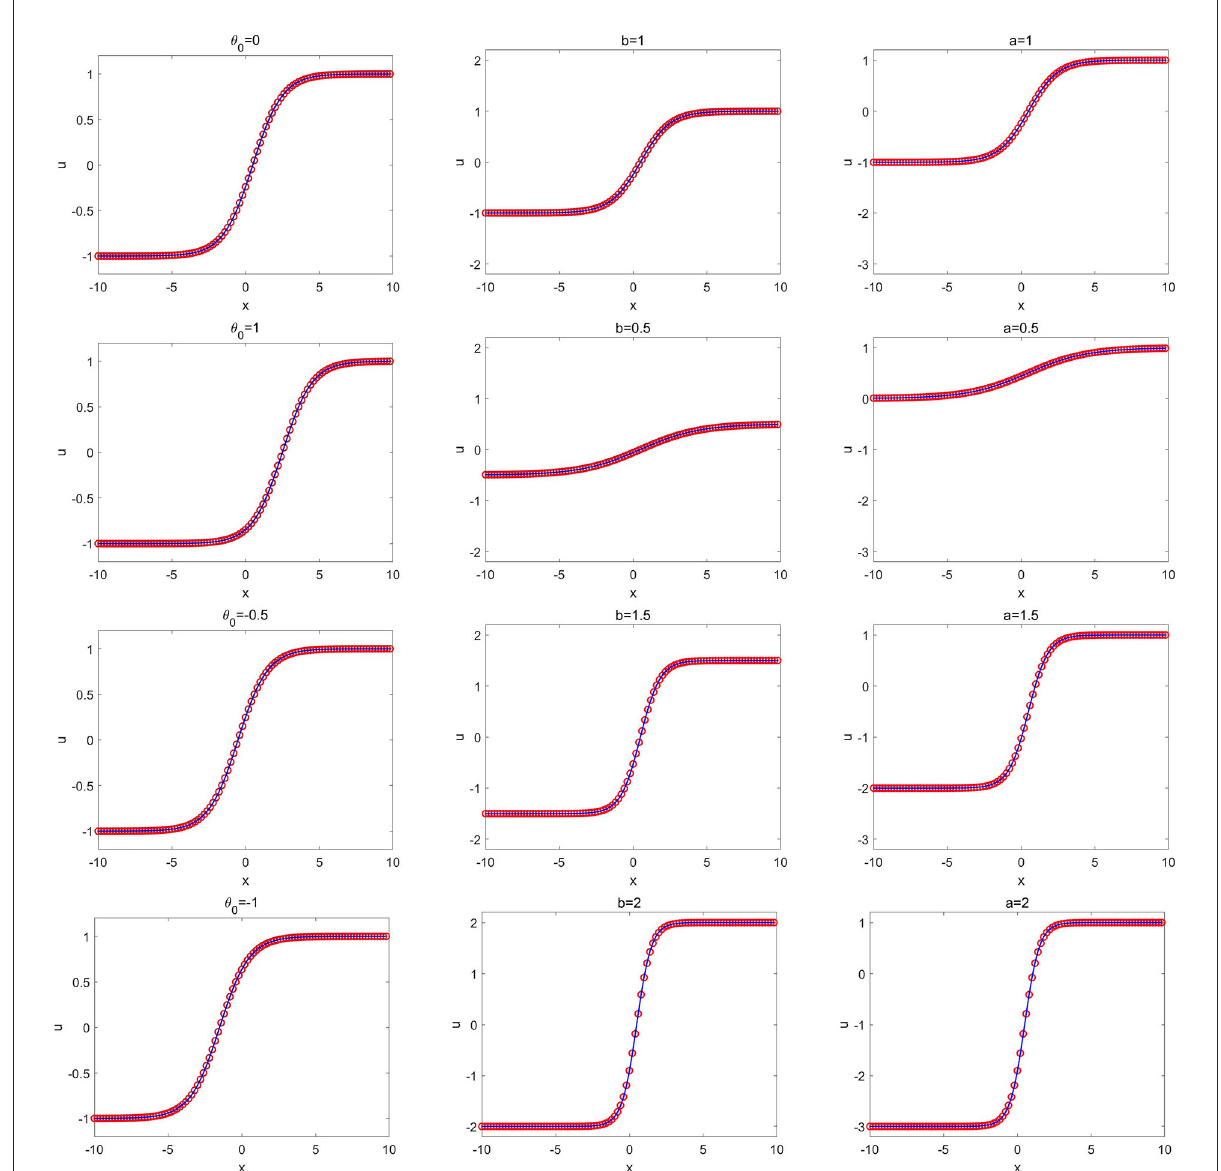
FIGURE7 mKdV-Burgers equation of Example 3.5: the CANN solution (red circles) and the exact solution (solid blue lines) at T of θ with a 1 and b 1; (Middle) Different values of b with a = =